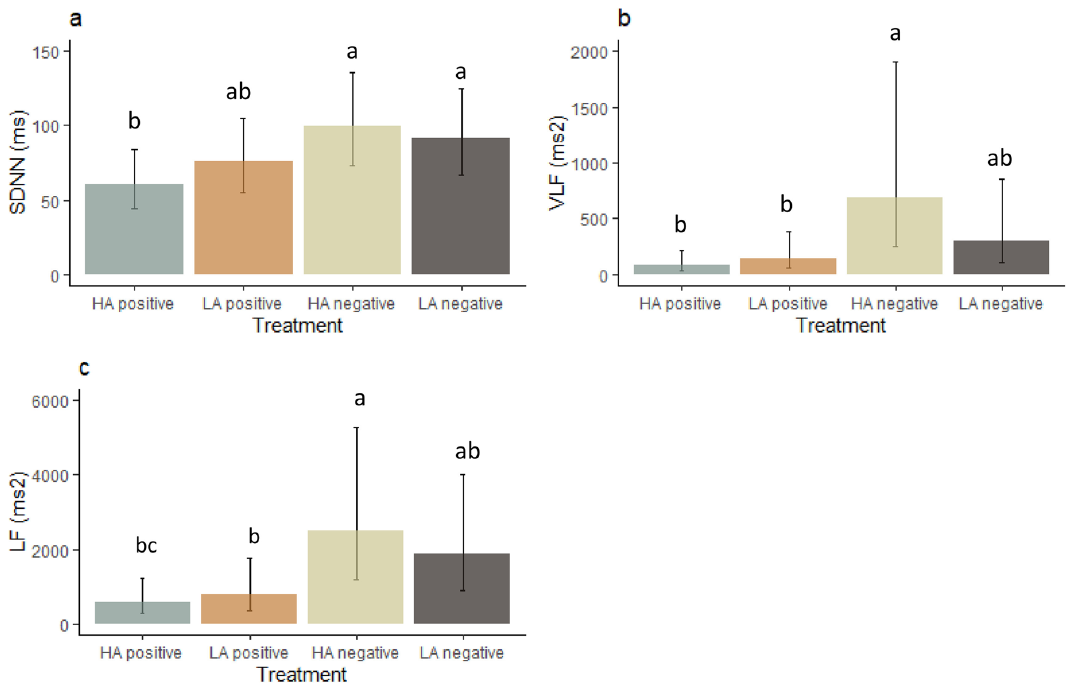
Figure 5. Effect of emotional treatment (Table 1) on heart rate variability indexes (mean ± CI), with ( a) SDNN, ( b) VLF and ( c) LF. HA high arousal, LA low arousal. Bars that do not share the same letter are significantly different from each other (P <